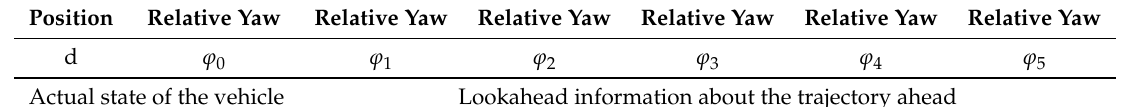
Figure 2. Different configurations of the lookahead sensor information part. Table 1. A configuration of the state